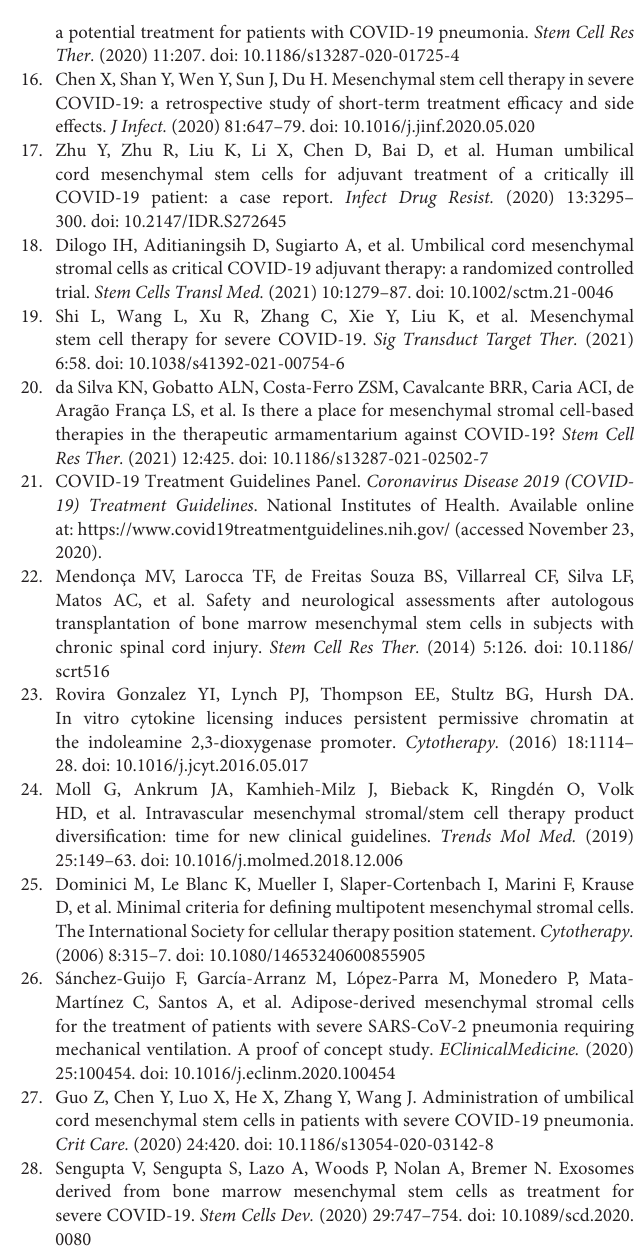
Supplementary Figure 3 | Gating strategy displaying the analysis of human monocytes. Peripheral Blood mononuclear cells (PBMCs) were stained using the panel indicated in the method section for quantitative analysis of chemokine receptor expression in monocytes. Samples were gated on monocytes based on SSC-A (complexity) and FSC-A (size) (A) , single events (B) HLA-DR+ and DUMP -